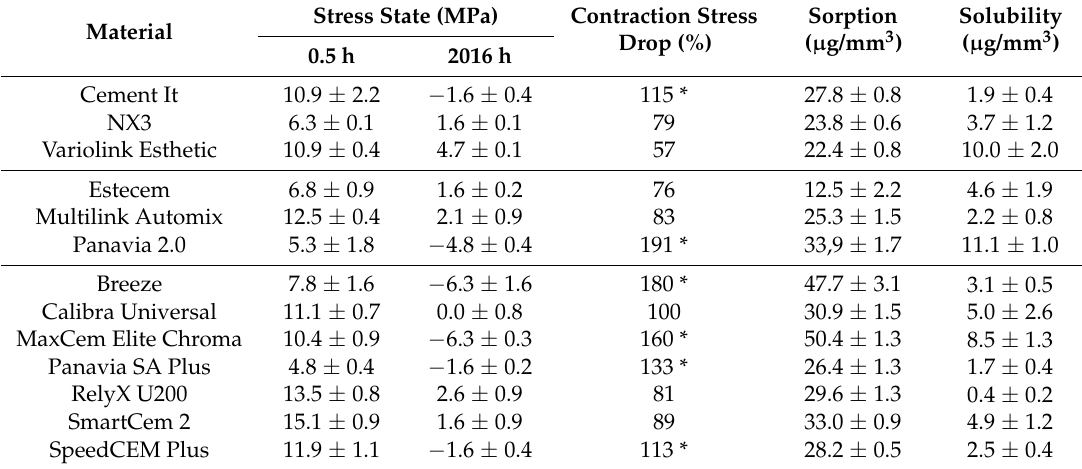
Table 3. Stress state before and after 2016 h (84 days) of water immersion, contraction stress drop, absorbency, and solubility of tested